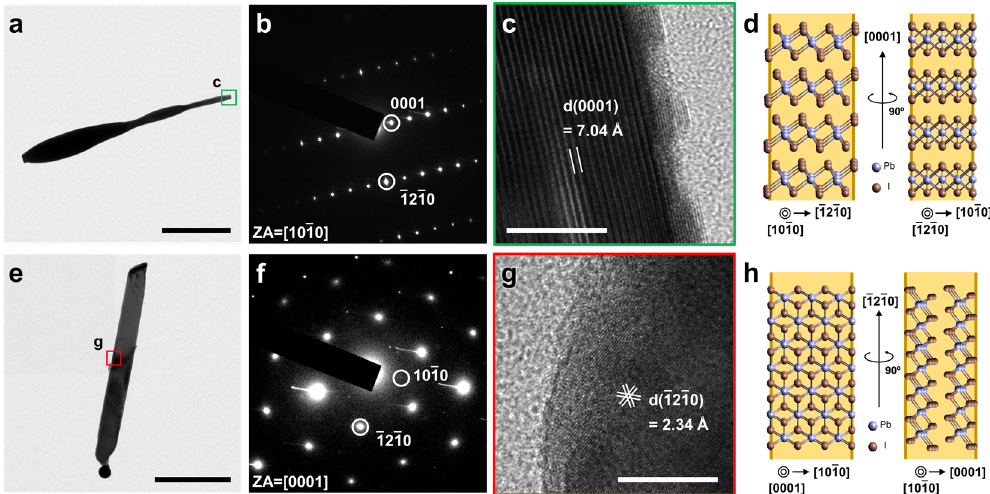
Figure 2. TEM investigations of the crystal structures for representative type A and type B PbI 2 nanowires. Low-magnification bright-field TEM images of ( a ) type A and ( e ) type B nanowires. Scale bars, 1 μ m. ( b , f ) Selected area electron diffraction pattern image corresponding to ( a ) and ( e ). ( c , g ) High-resolution TEM images of the nanowires denoted by the boxes in ( a ) and ( e ). Scale bars, 10 nm. Schematic illustrations of ( d ) type A and ( h ) type B PbI 2 nanowire sidewall configurations.